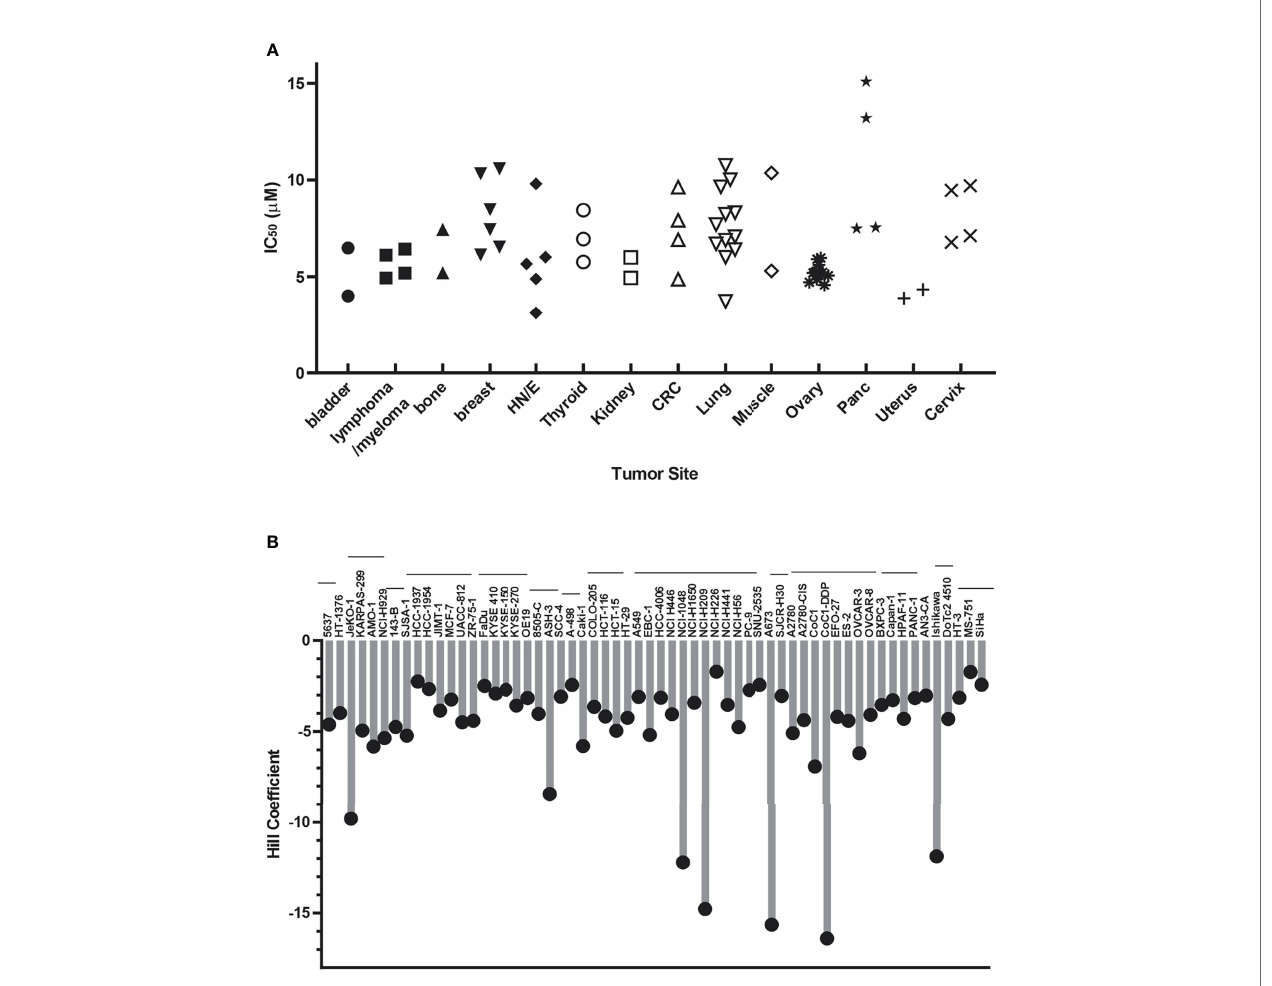
FIGURE 4 | Cellular activity of 329 in 60 cancer cell lines. Cell lines were treated with a 4-log range of replication protein A inhibitor (RPAi) 329 for 72 h. Cell viability was assessed using CellTiter-Glo luminescent viability assay. The data represent the average of triplicate treatments, and the data were fi t using non-linear regression analysis to calculate cellular IC 50 s. (A) IC 50 results from each cell line grouped by tumor type. (B) Hill coef fi cients for individual cell lines. The horizontal lines above cell line names indicated the tumor sites in the order depicted in panel (A)